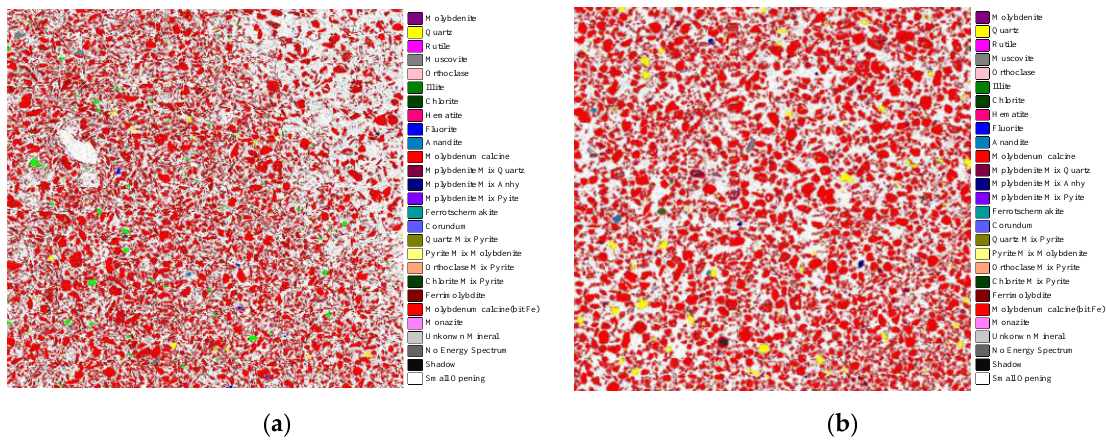
Figure 8. MLA scan analysis images under different conditions. ( a ) MLA scan analysis image of humidified molybdenum calcine; ( b ) MLA scan analysis image of Non-humidified molybdenum calcine. It can be seen from the results in Table 5 that the orthoclase content of the humidified Table 5. MLA analysis results of washed molybdenum calcine under different conditions/%. sample is 0.03%, which is significantly lower than that of the normal sample without humid- ification (0.17%). The main reason is that the humidification can facilitate more of the SO 2 oxidized from molybdenum concentrate adhering to the surface of molybdenum concen- trate particles in the form of H 2 SO 4 . Combined with the analysis results in Section 3.3,